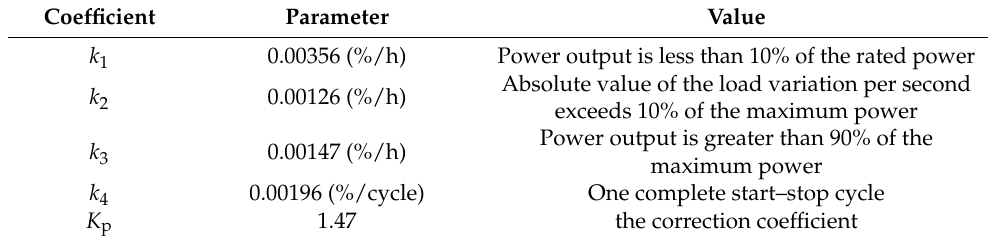
Table 3. Attenuation model